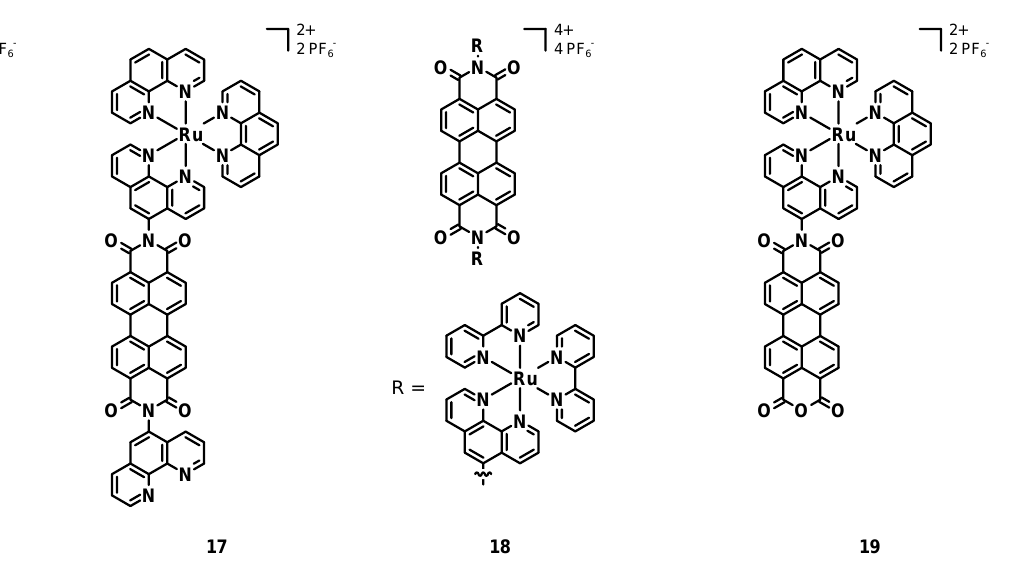
x = 12 Figure 7. Structure of complexes 15a – c . The UV – Vis spectra in DMF were constituted by strong 1 MLCT absorption bands at 497 nm, 1 LC at 288 and 313 nm, and one at 570 nm associated with the perylene π - π* transition. The increasing molar extinction coefficient of the bands at 288, 313, and 497 nm passing from 15a to 15c was a consequence of the increasing number of metal centers.